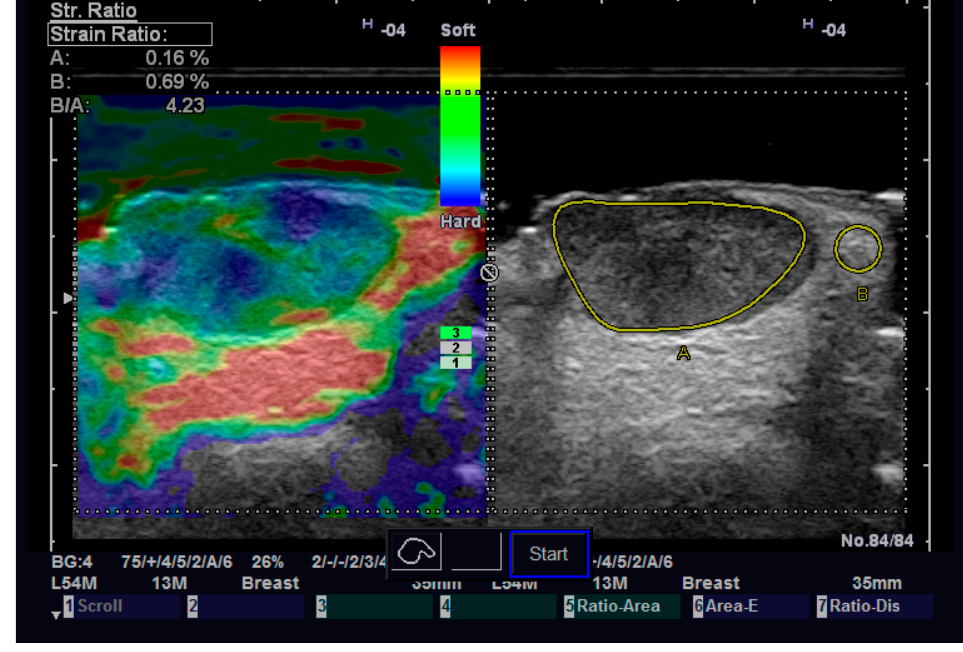
Figure 6. Strain elastography of a SCC.